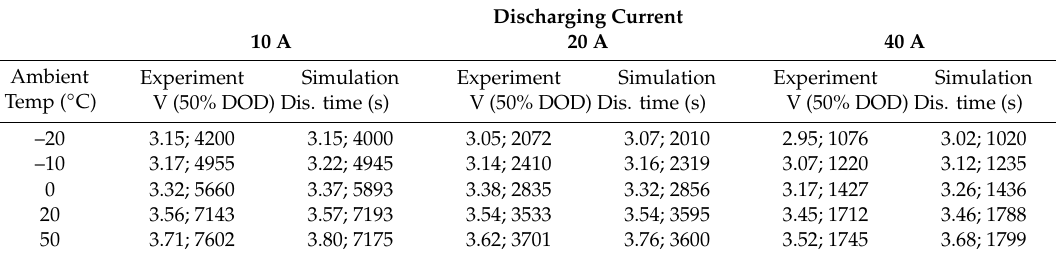
Figure 8. Examples of comparisons between simulated and experimental 20A discharging curves in battery module: ( a ) 0 ◦ C; ( b ) 50 ◦ C. Table 1. Summary of comparisons between experimental and simulation